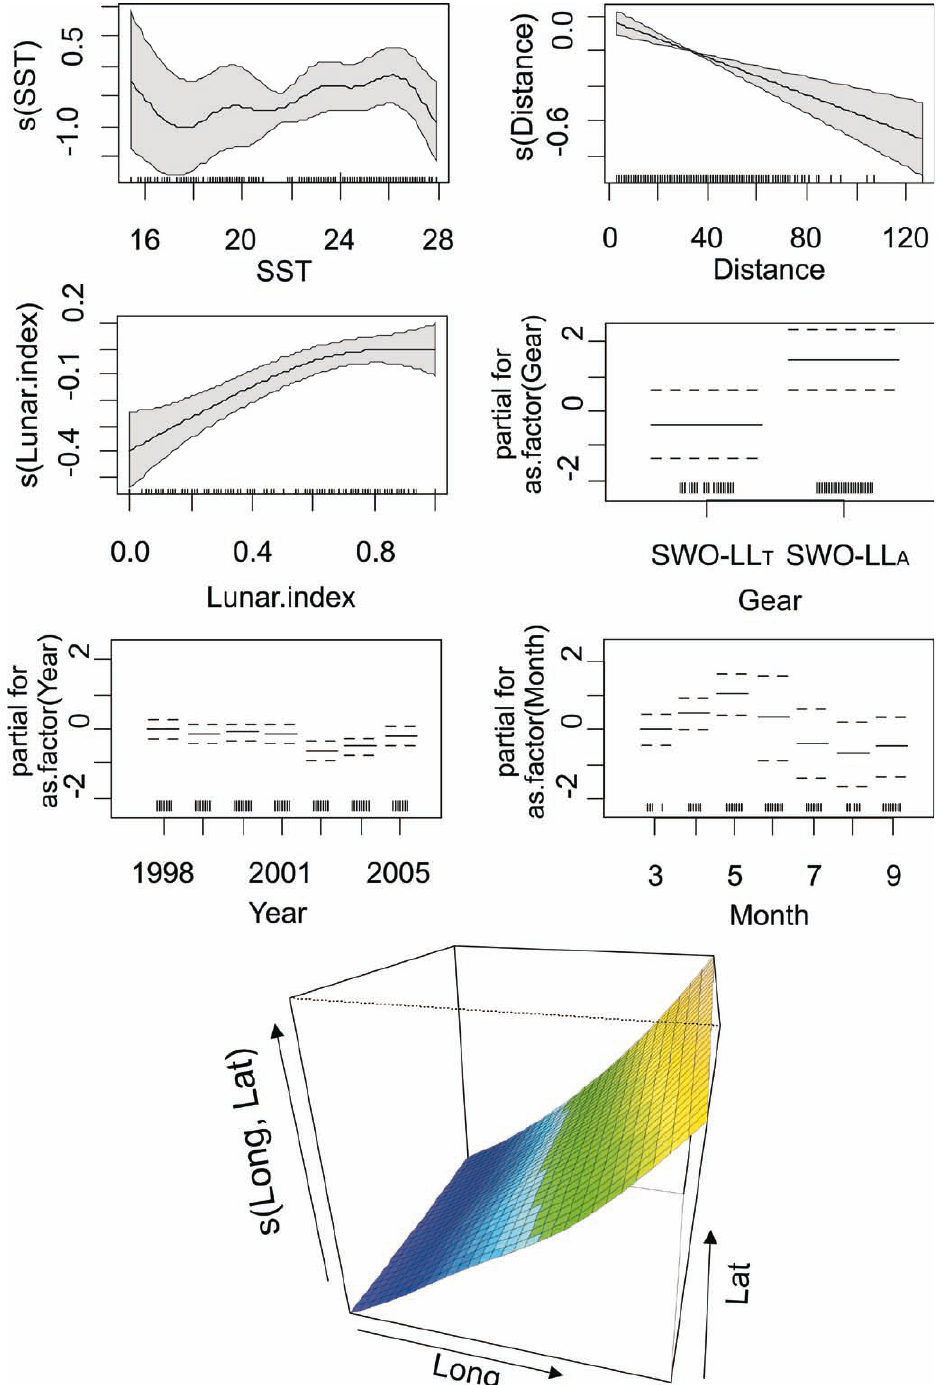
Fig . 3. – Generalized additive model (GAM) derived effects of the investigated parameters on the Delta-Gamma (log) probability of positive bluefin tuna catch rates (school size – presence-absence sub-model). Shaded areas indicate two standard errors above and below the estimates. Relative density of data points is shown by the ‘rug’ on the